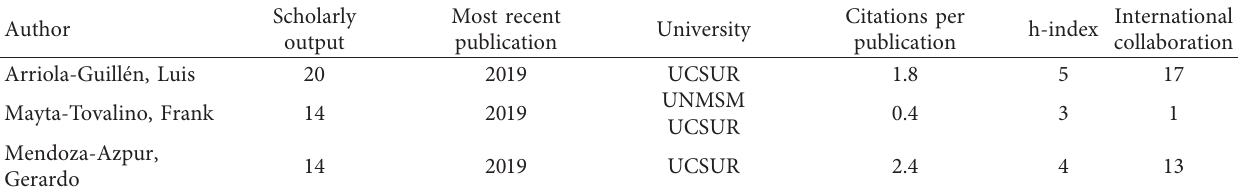
Source: Scopus/SciVal and 26.5% of publications in the top 25% journal percentiles